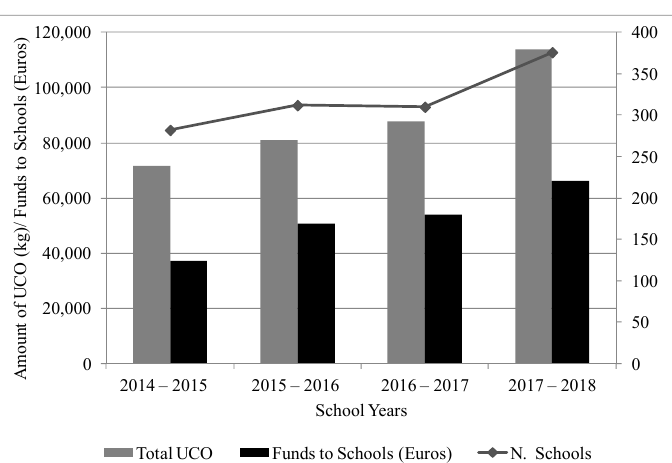
Figure 1. Number of participating schools, used cooking oil (UCO) collected, and funds received by schools from 2014 to